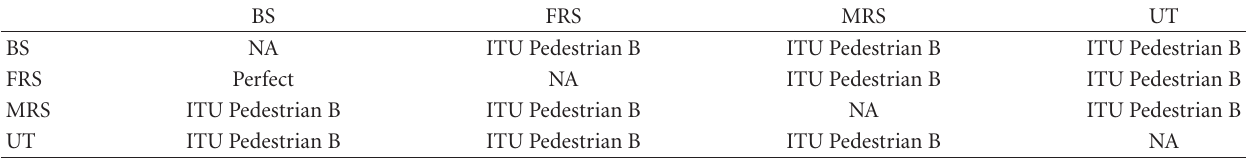
Table 4: Channel between BS and